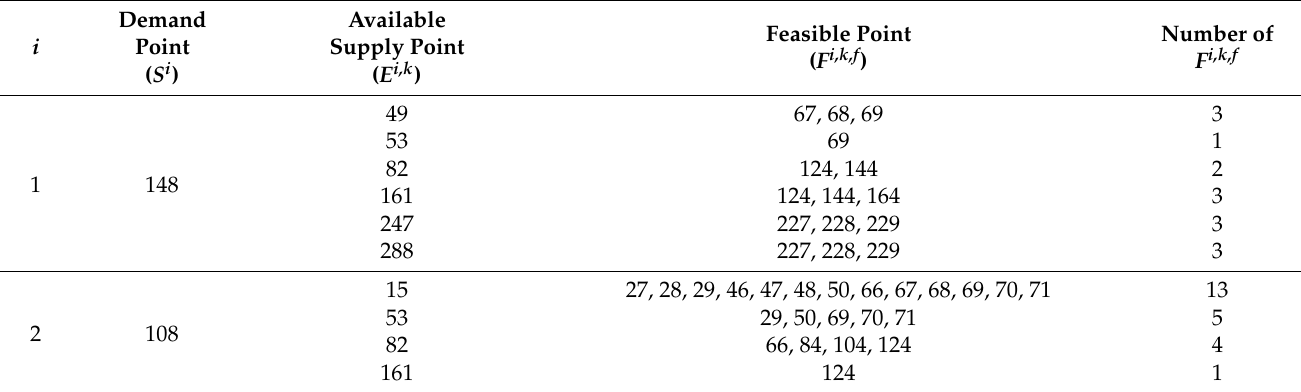
Table A1. Demand points, available supply points, feasible points of case